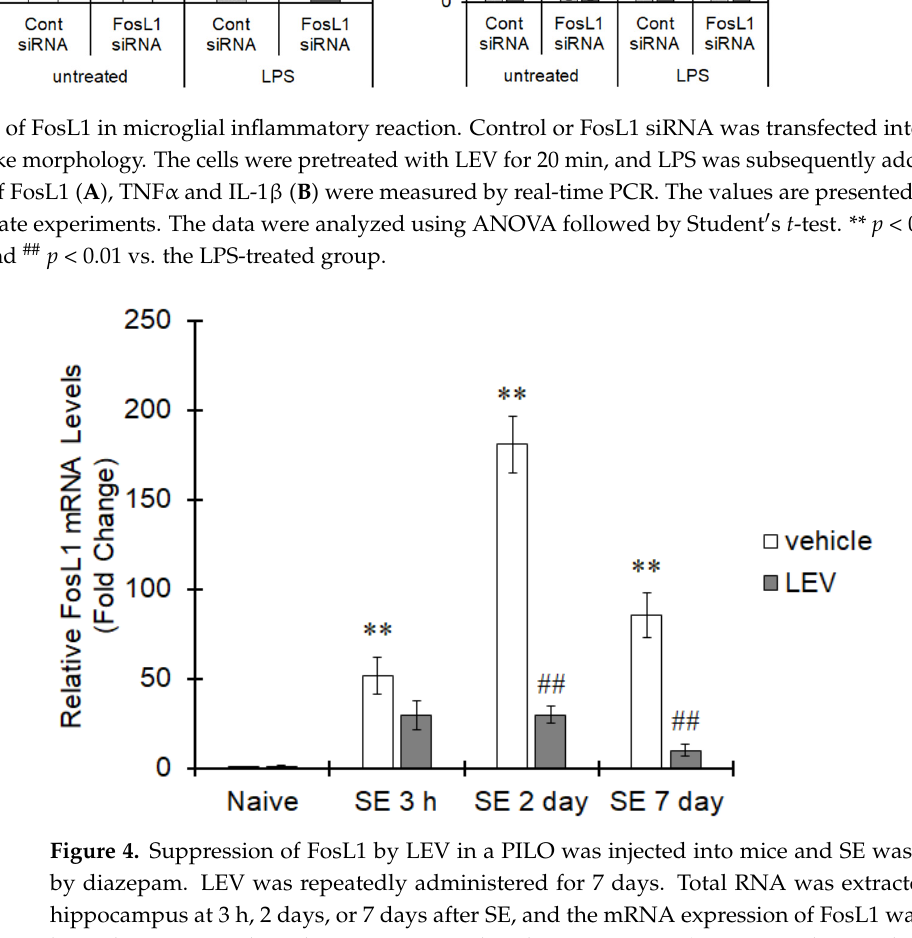
Figure 4. Suppression of FosL1 by LEV in a PILO was injected into mice and SE was terminated by diazepam. LEV was repeatedly administered for 7 days. Total RNA was extracted from the hippocampus at 3 h, 2 days, or 7 days after SE, and the mRNA expression of FosL1 was evaluated by real-time PCR. The values are presented as the mean ± S.E. ( n = 5 animals in each group). The data were analyzed using ANOVA followed by Dunnett ′ s test or Student ′ s t -test. ** p < 0.01 vs. naïve mice and ## p < 0.01 vs. PILO mice.